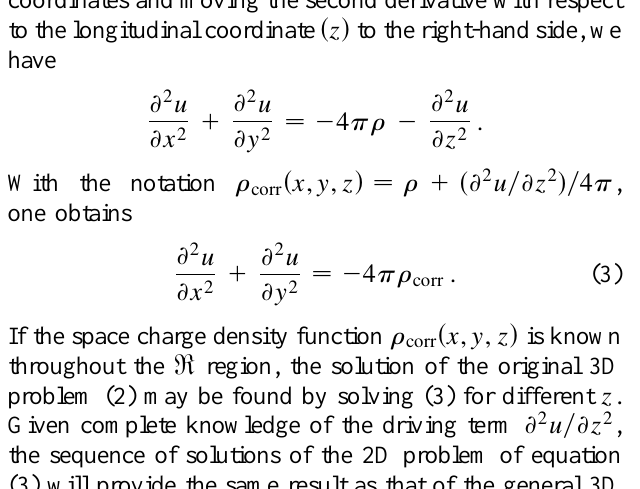
FIG. 7. Illustration of the sub-3D computational scheme. A specific thick slice with z T (cid:1) 0 and width H T Z is